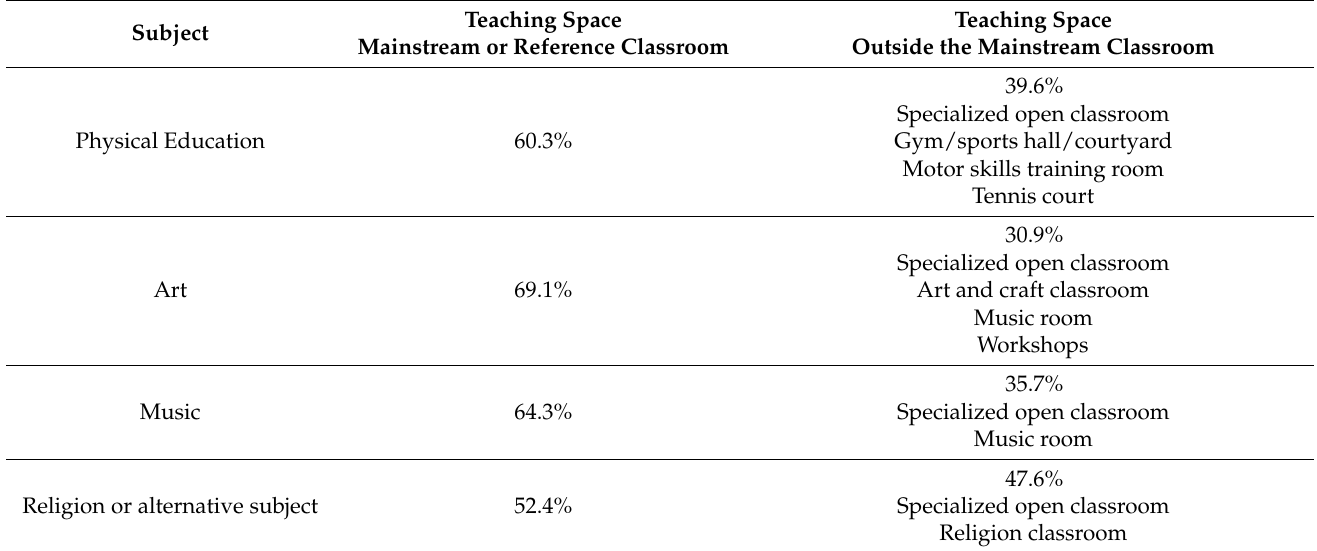
Table 3. Spaces where the subjects contemplated in the guidelines are